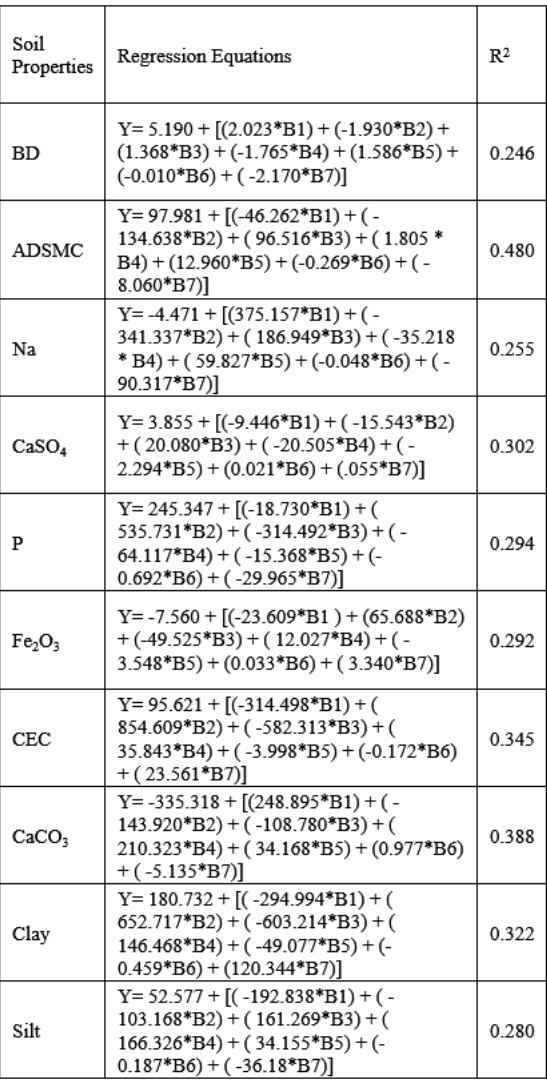
Table 2. The regression equations, which were used for soil properties